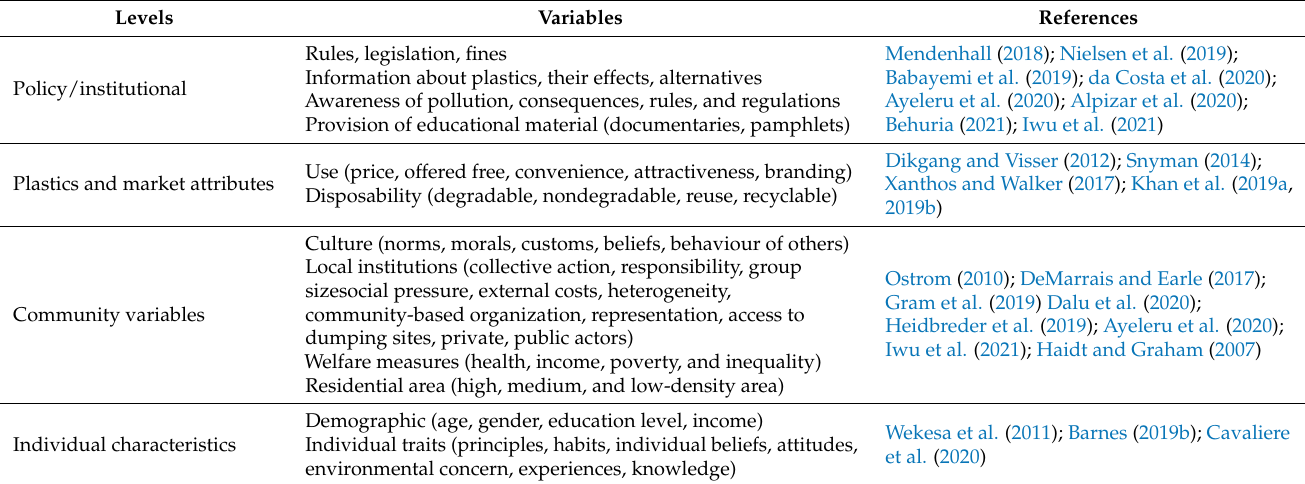
Table 2. The drivers of consumer perceptions of environmental